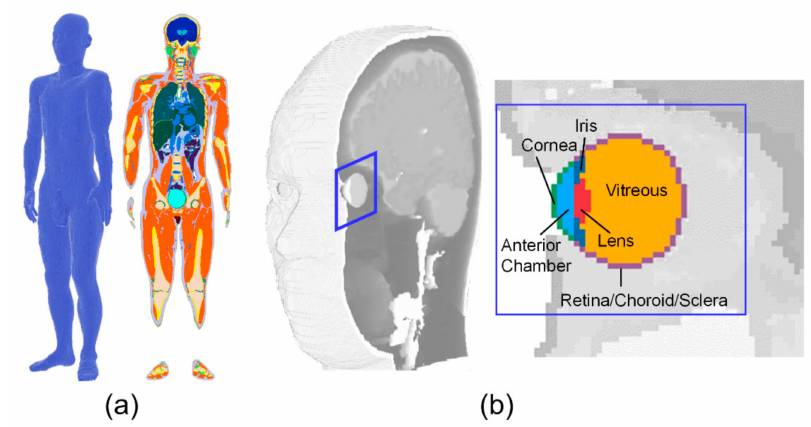
Figure 1. The human model and anatomy around the eye: ( a ) whole-body anatomical human model; ( b ) eye anatomy (derived from the whole-body